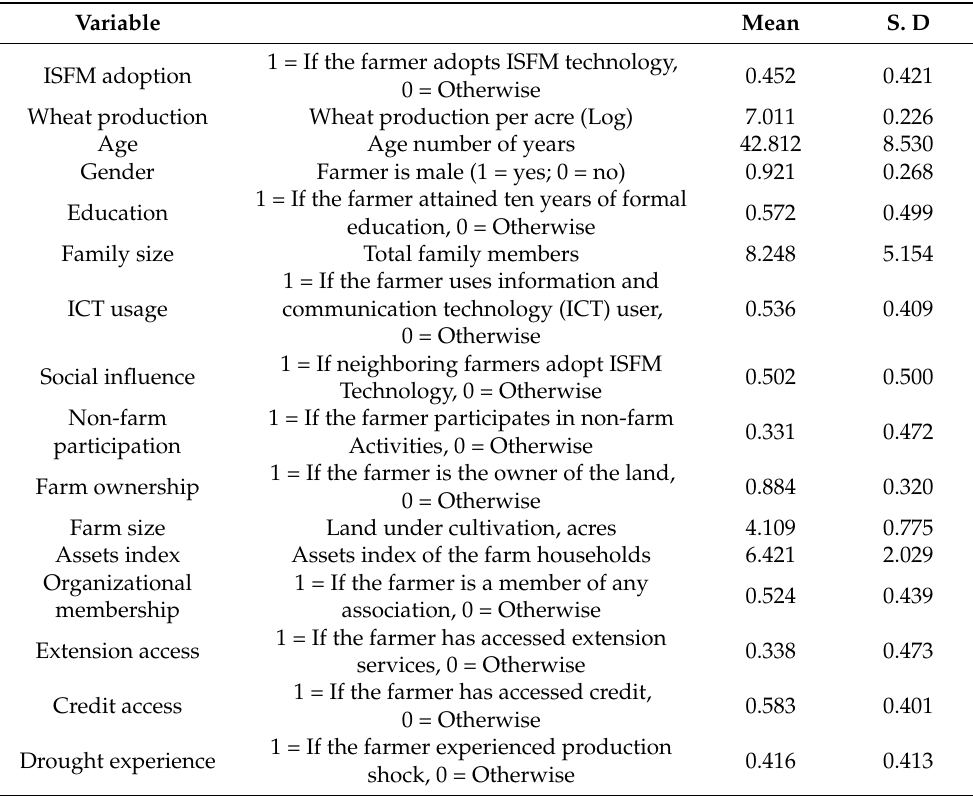
Table 1. Descriptive statistics and definition of the